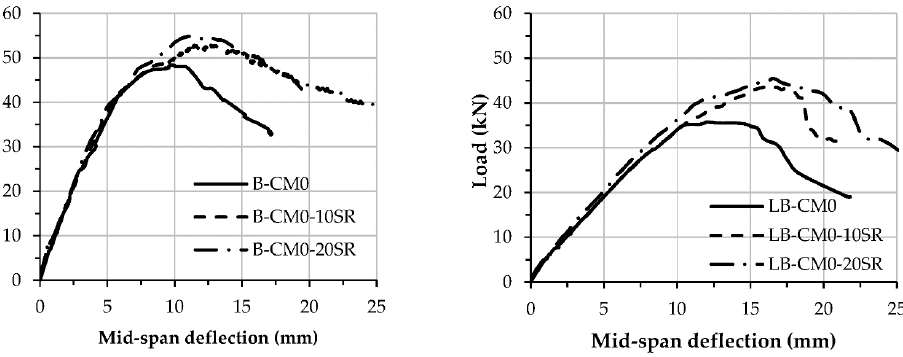
Figure 12. Load vs. mid-span deflection relationship of stiffened specimens with screws.